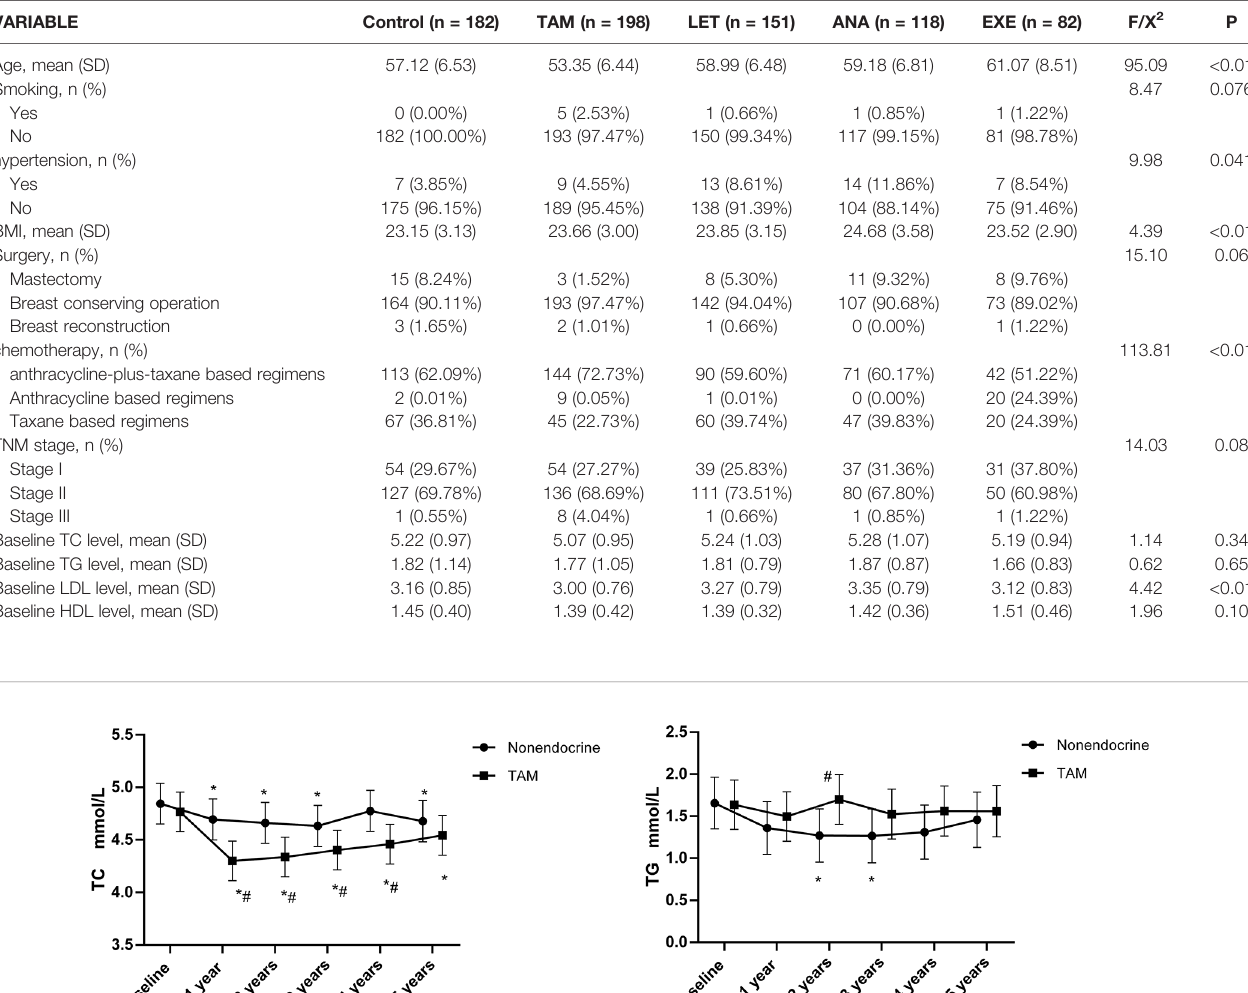
TABLE 2 | Baseline characteristics of postmenopausal breast cancer patients.